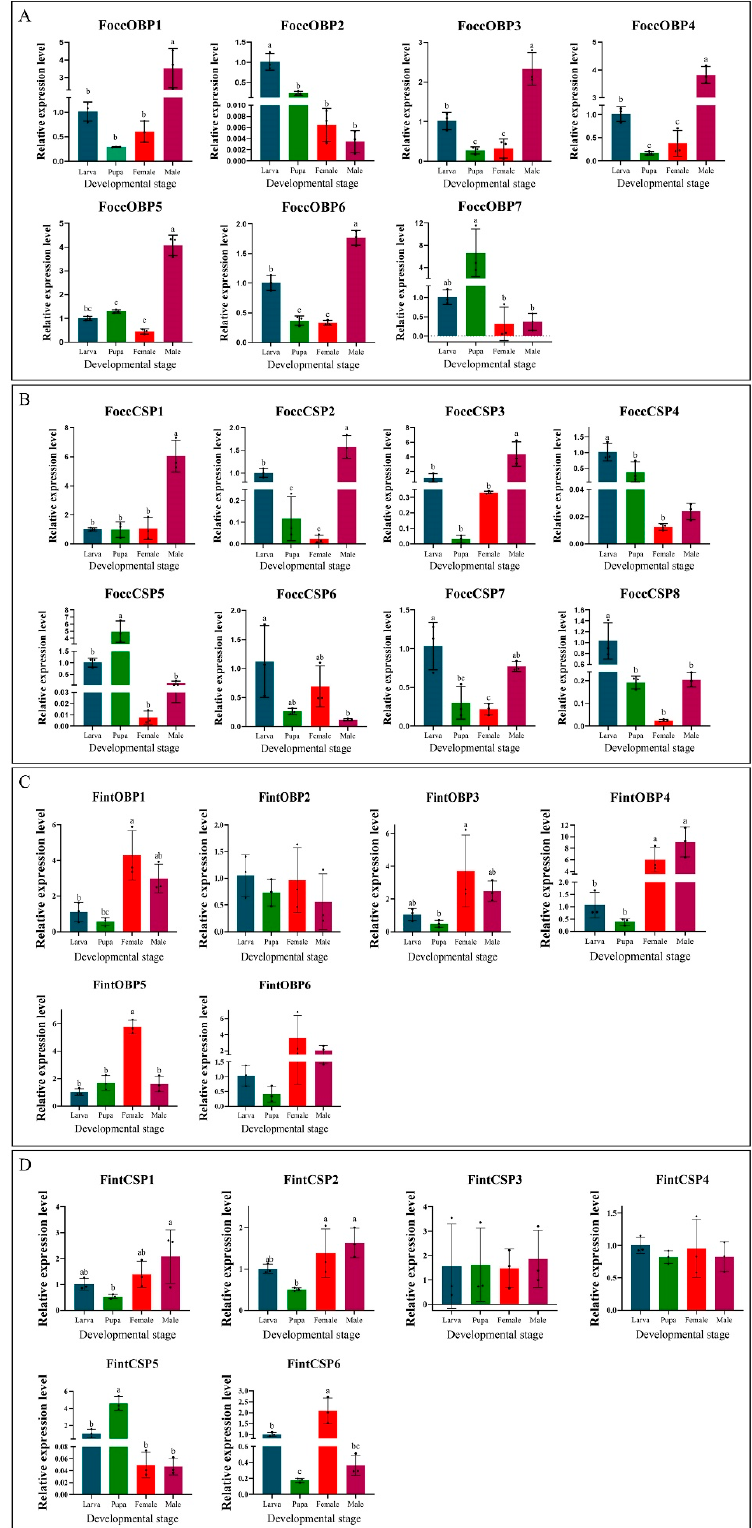
Figure 7. Expression analyses of OBP ( A ) and CSP ( B ) genes of Frankliniella occidentalis , and OBP ( C ) and CSP ( D ) genes of Frankliniella intonsa in different developmental stages by qRT-PCR. The bar represents the standard error, and the different letters above each bar indicate significant differences ( p <